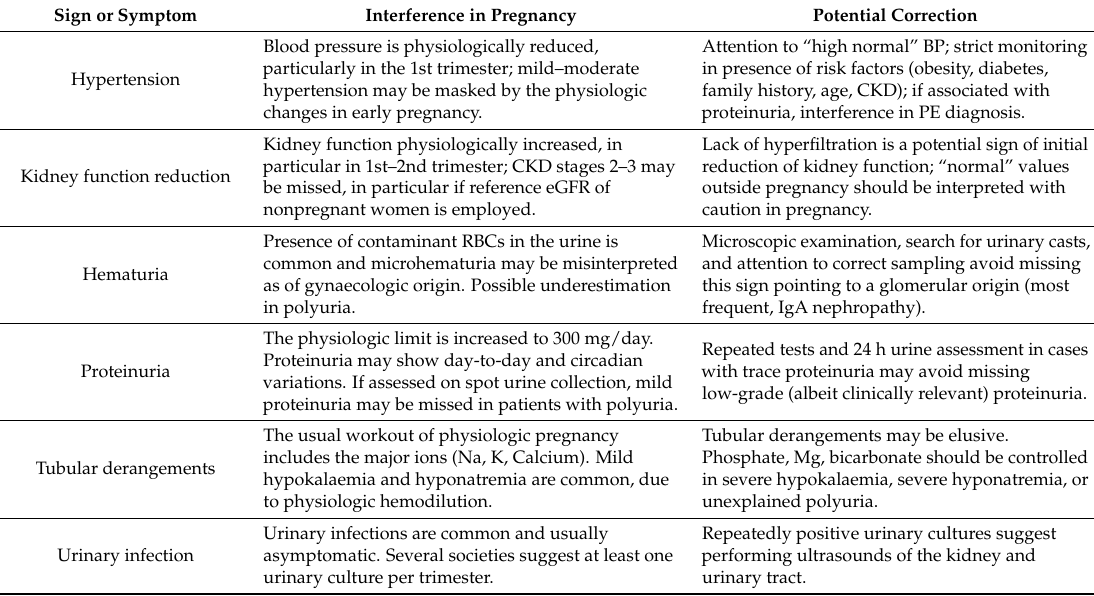
Table 4. Challenges for the diagnosis of kidney diseases in